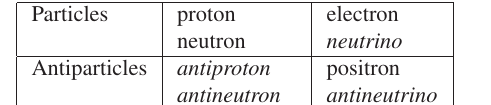
Table 1. Particles of matter and their antiparticles, 1934 (hypothesized particles are indicated in italic font).